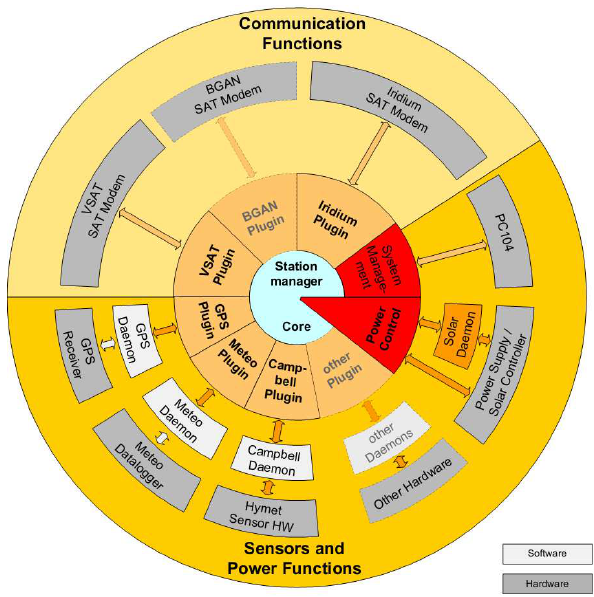
Fig. 4: ROMPS Software concept for the station management. Other hardware and daemons 2 Fig. 4. ROMPS Software concept for the station management. Other (gray letters) can be integrated. Modified after Kloth (2008). 3 hardware and daemons (gray letters) can be integrated. Modified after Kloth (2008).